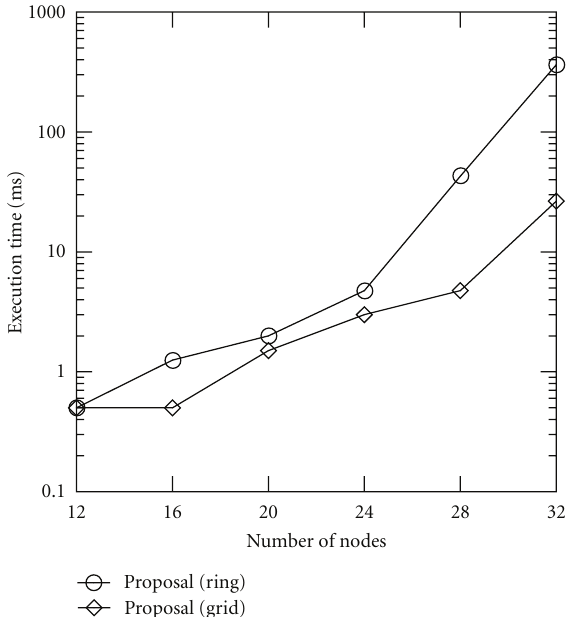
Figure 12: Execution time of the proposed algorithm versus the number of nodes on the grid and ring network model.